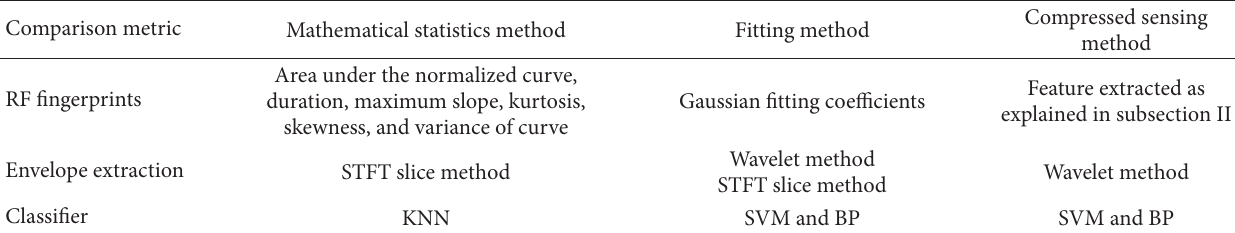
Table 2: Comparison of identification of a transmitter using three different methods.